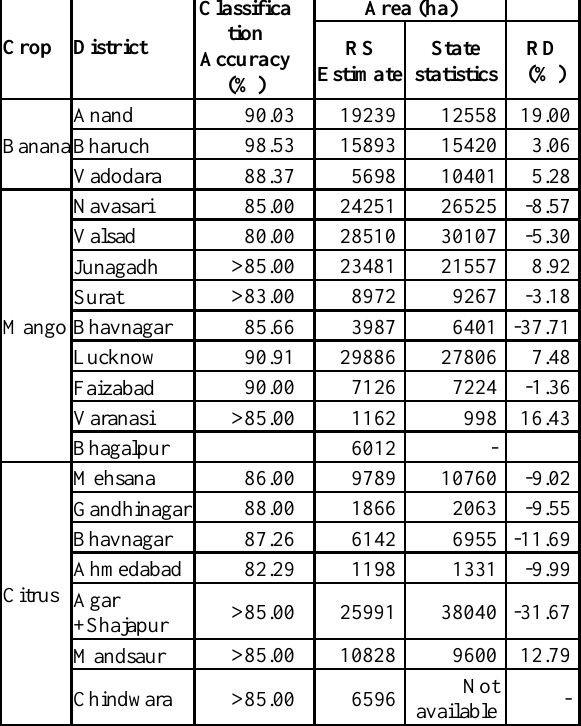
Table 2. Crop area of banana, mango and citrus in their major growing districts, classification accuracy and relative deviations compared to reported